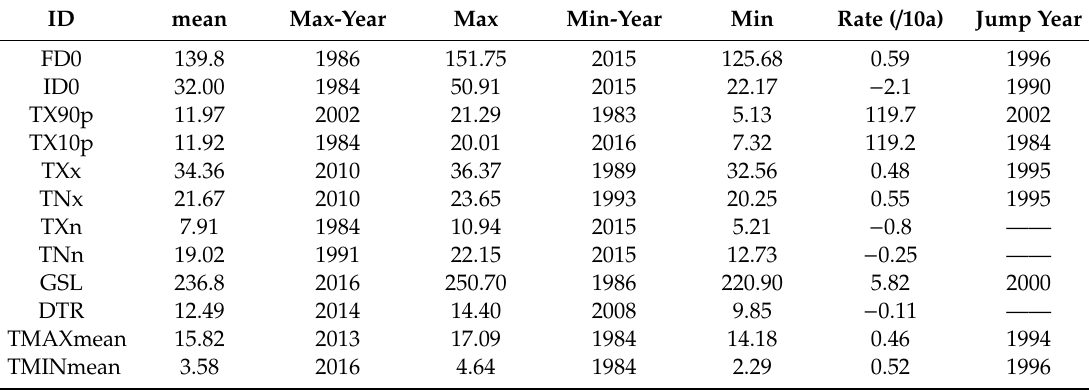
Table 5. Statistical results of abrupt trend analysis of extreme climate